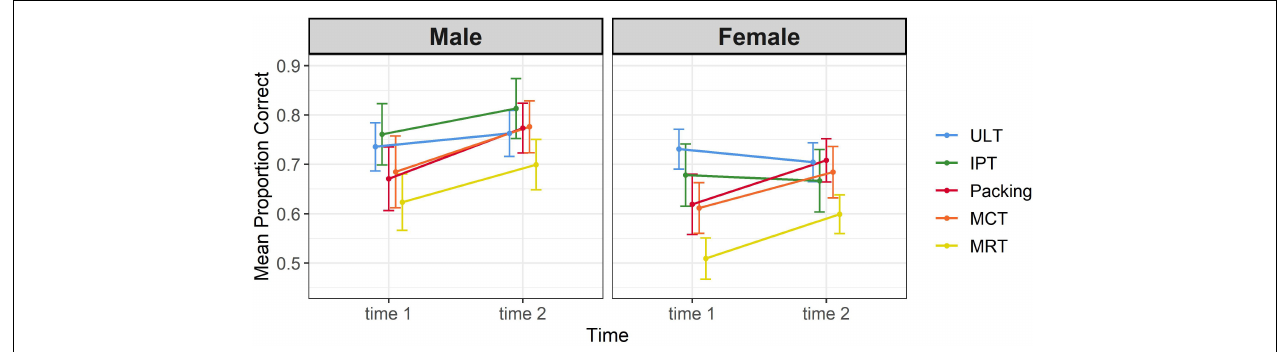
FIGURE 6 | Test scores at two time points by gender. Error bars indicate 95% confidence